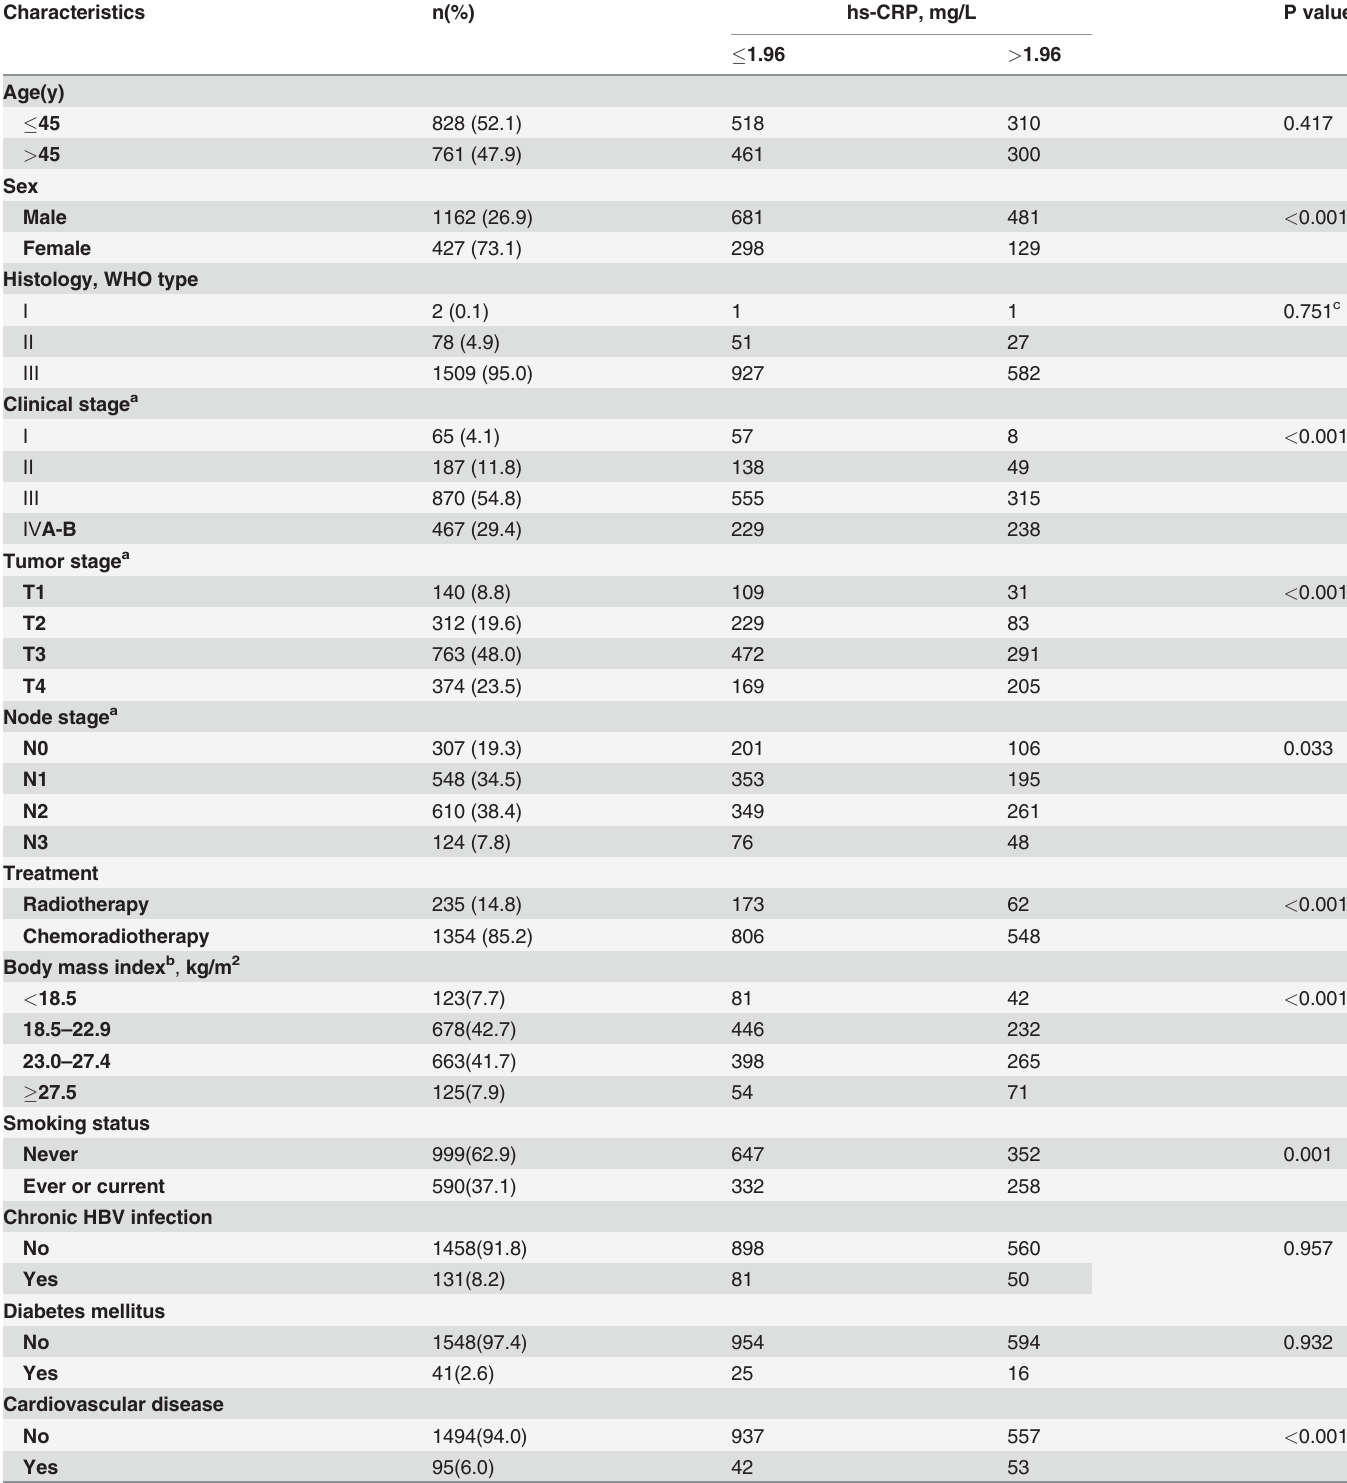
Table 1. Patient